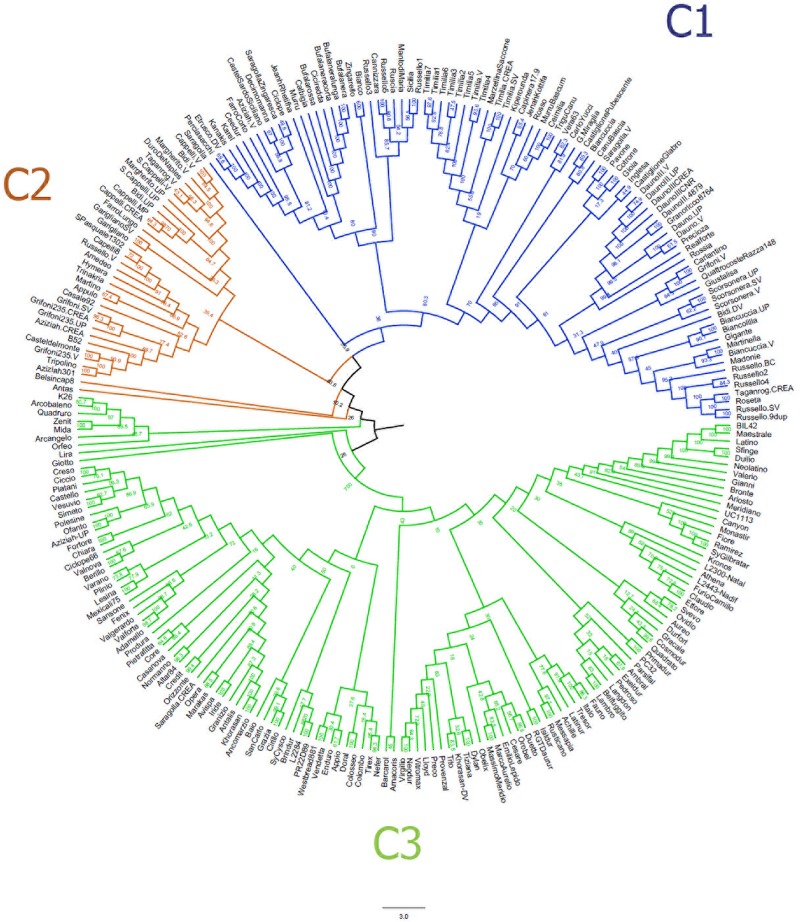
Neighbor-joining tree based on the genetic distances for 259 durum wheat accessions using 3,541 single nucleotide polymorphisms. Accessions are colored in blue (landraces), orange (old cultivars) and green (modern cultivars).